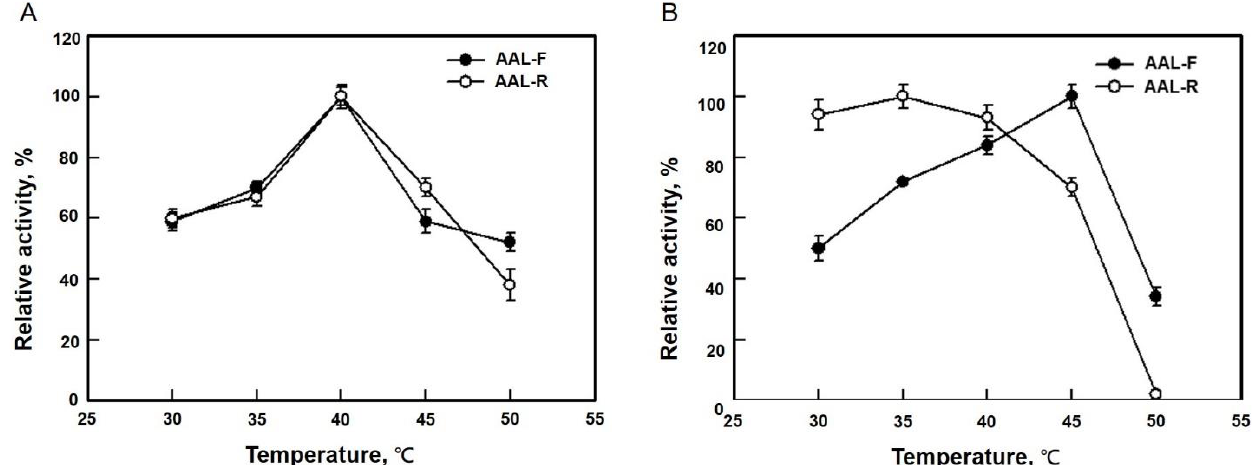
Figure 3. Optimum reaction temperature of AAL-F and AAL-R activities of LpAAL ( A ) and MBP- LpAAL ( B ) enzymes. Activities were measured under standard assay conditions in a range of temperatures from 30 to 50 ◦ C. All experiments were performed in triplicate and expressed as average ± standard deviation (S.D., error bars). The average of maximum activity was normalized as 100%.